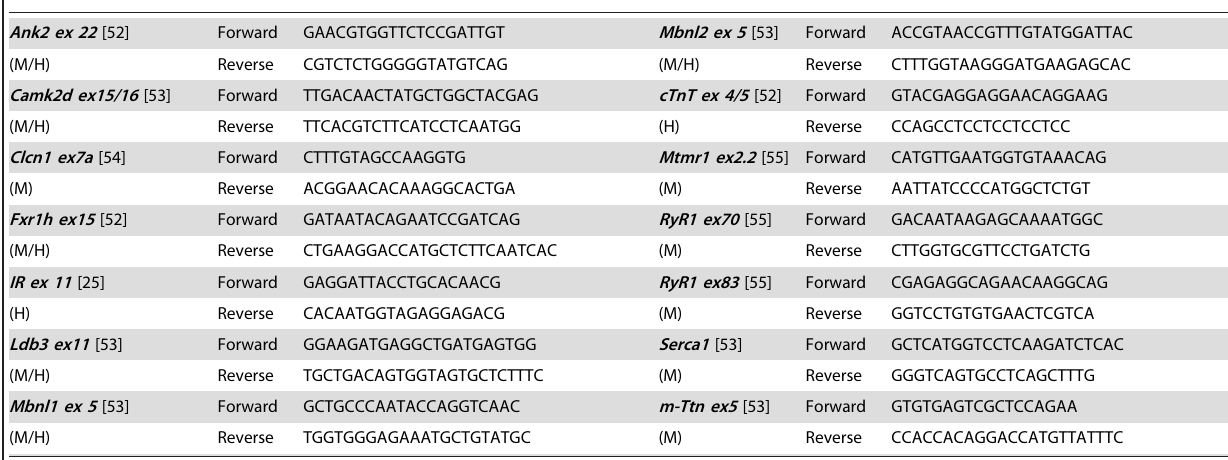
Table 1. List of primers used for RT–PCR splicing